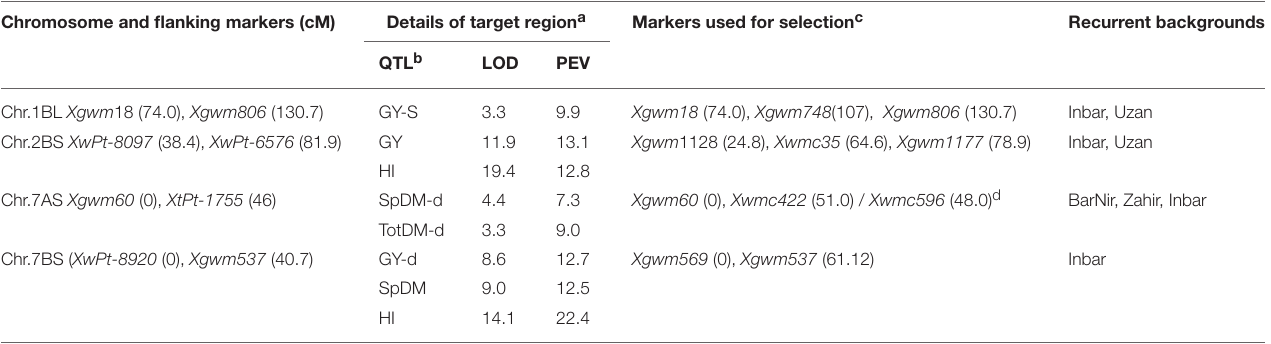
TABLE 1 | Drought-related QTL regions targeted for introgression from wild emmer wheat acc. G18-16 into bread and durum wheat cultivars, SSR markers used for selection, and recurrent backgrounds of the introgression lines. Chromosome and flanking markers (cM) Details of target region a Markers used for selection